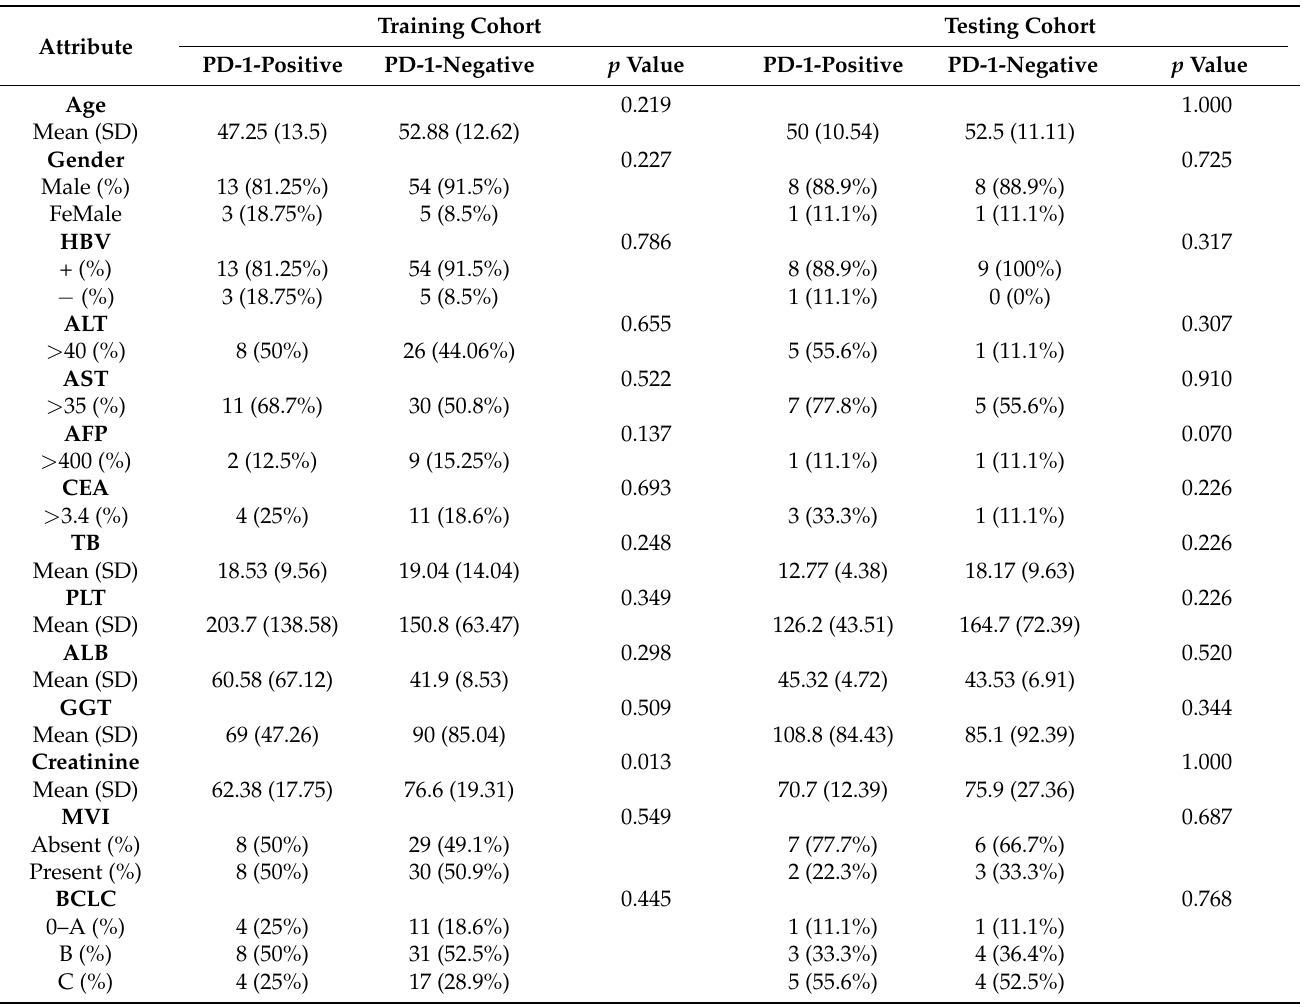
Table 1. The statistics of HCC patients in the training and testing